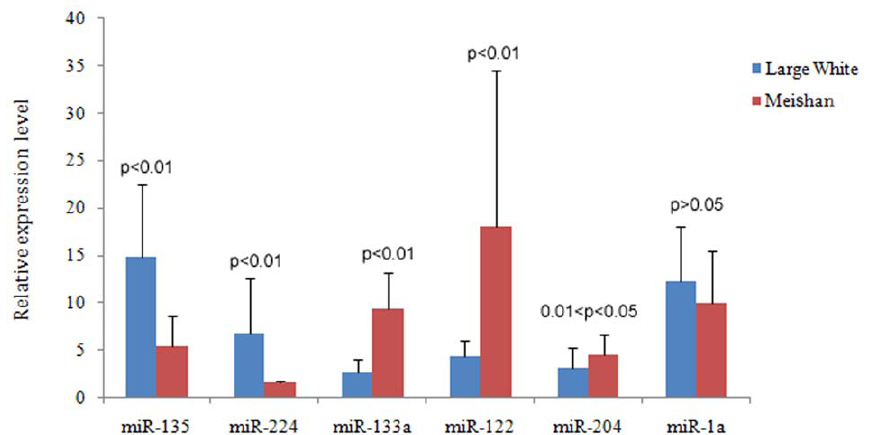
Figure 3. Validation of the miRNAs with significantly differential expressions using stem-loop qPCR method. Expression levels of 6 miRNAs were detected by Real-time PCR. The number of biological replicates is three. The corresponding significance value (p) was shown above their respective columns. 0.01 , p , 0.05 was considered to be significant and p , 0.01 significantly different.